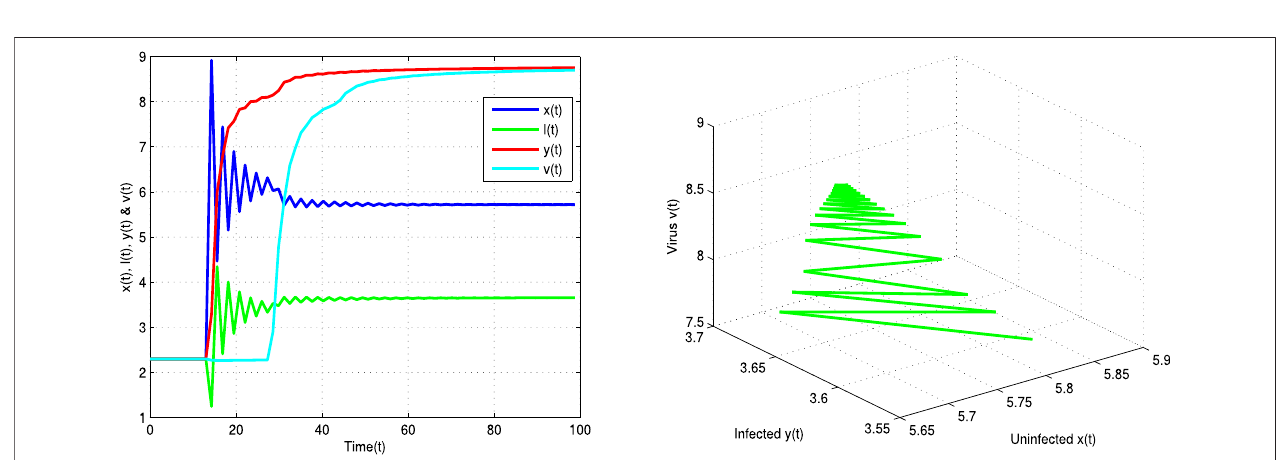
FIGURE2| Timetrajectoriesforuninfectedcells x ( t ),latentlyinfectedcells l ( t ),infectedcells y ( t ),andviruses v ( t )of Eq.2 with τ (cid:2) 14 > τ * (cid:2) 13.5, α (cid:2) 0.9 (leftbanner) and α (cid:2) 0.8 (right banner) .